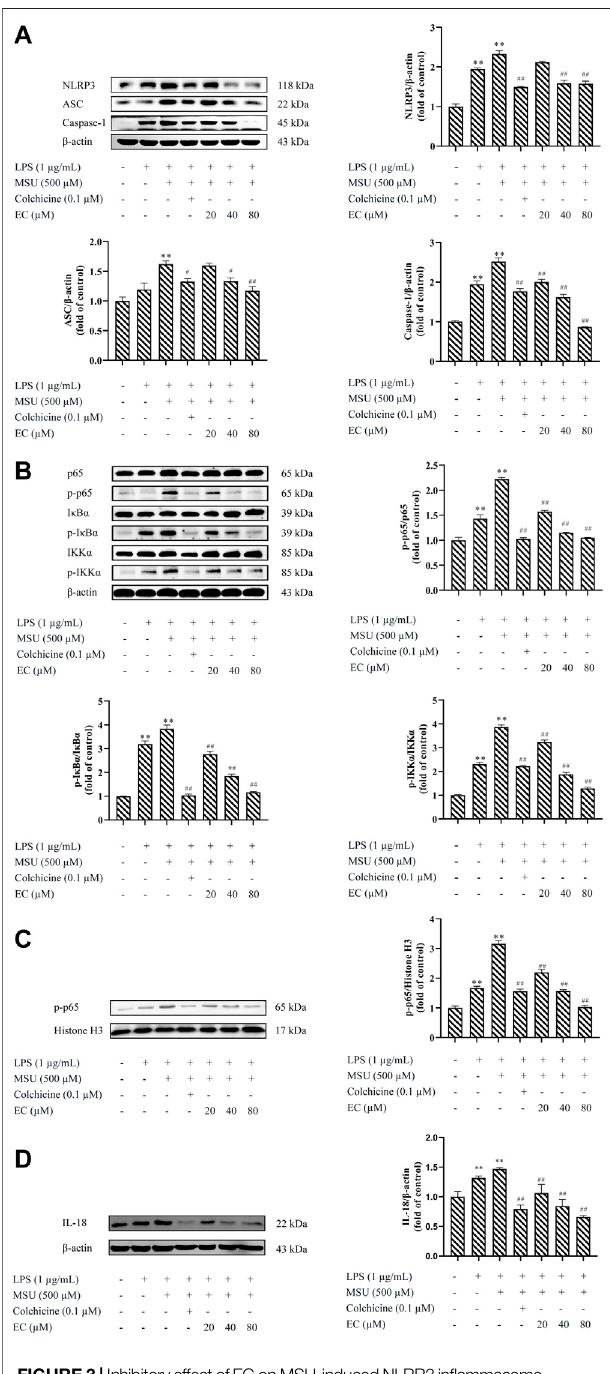
FIGURE3| InhibitoryeffectofEConMSU-inducedNLRP3in fl ammasome and NF- κ B pathway-related protein expression in vitro. (A) The protein expressions of NLRP3 in fl ammasome components in THP-1 cells. (B) Related proteinsexpressionsoftheNF- κ Bsignalingpathway. (C) ExpressionofNF- κ B translocation. (D) IL-18 expression in THP-1 cells. Data are represented as mean ± SEM of three independent experiments. ** p < 0.01 compared with the control group; # p < 0.05 or ## p < 0.01 compared with the LPS + MSU group.